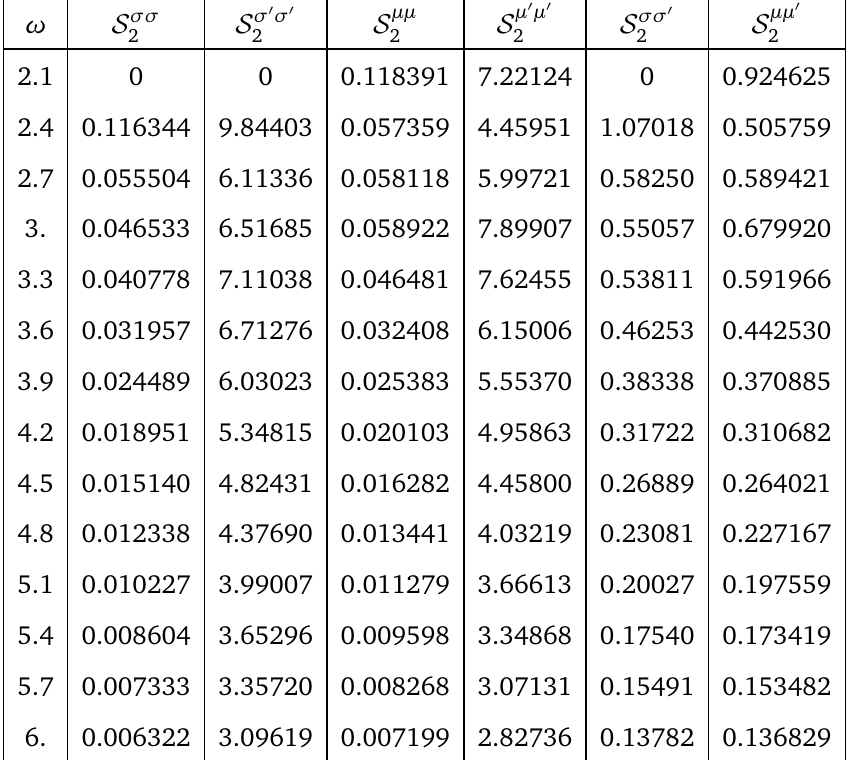
Table 7.3: Two-particle contributions to various dynamical structure factors calcu- lated from the form-factor solution presented in the previous